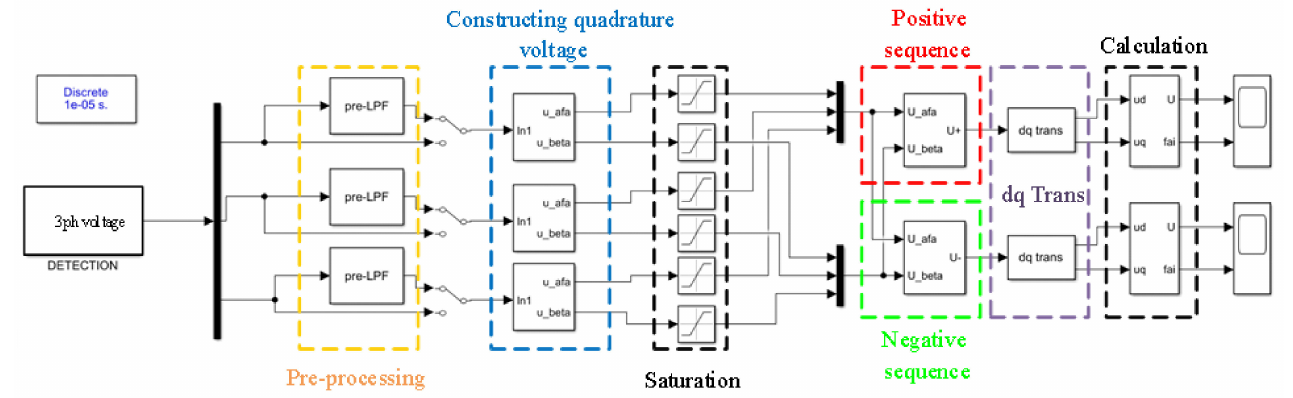
Figure 9. MATLAB/Simulink simulation model.